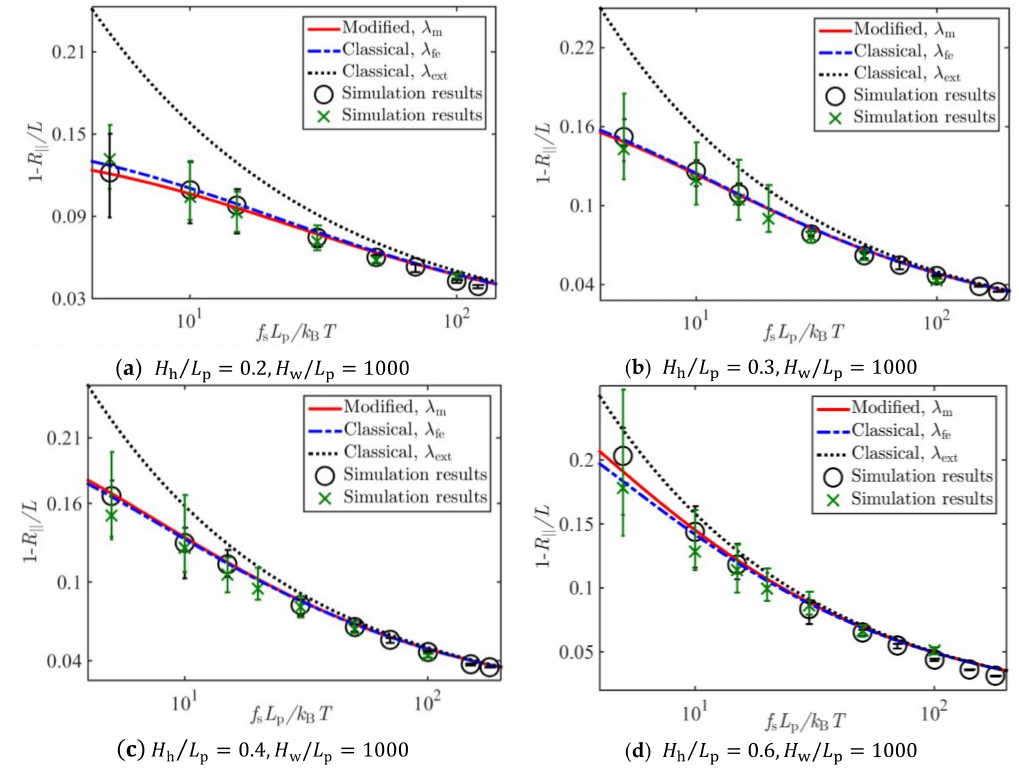
Figure 7. Comparison of Brownian dynamics simulations and theoretical predictions on the relative average extension of a WLC under stretching forces and confinements of slits with sizes ( a ) H h / L p = 0.2, H w / L p = 1000, ( b ) H h / L p = 0.3, H w / L p = 1000, ( c ) H h / L p = 0.4, H w / L p = 1000, and ( d ) H h / L p = 0.6, H w / L p =